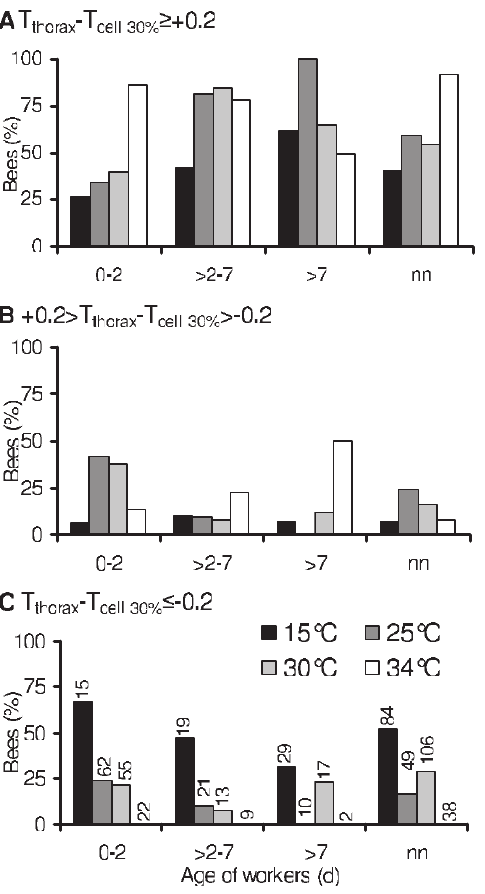
Figure 8. Heat transfer between bees in cells and brood combs. Percentage of workers of different ages in brood nest cells with (A) higher T thorax than T cell 30% , (B) approximately equal T thorax and T cell 30% , and (C) lower T thorax than T cell 30% , in dependence on thermal stress (T exp = shading of bars). Sample numbers in (C) represent 100%. nn = naturally emerged, unmarked bees. nn bees did not differ from the averaged age classes of marked bees (P . 0.1; Chi 2 2.706 =0.00–2.143) with exception of bees at T exp =30 u C in (B) (P , 0.05; Chi 2 3.841 =4.163).